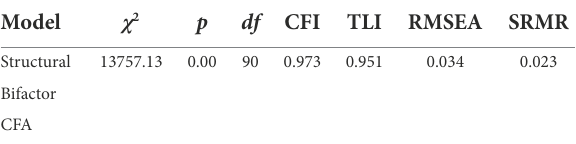
TABLE 5 Fit indices for the structural model based on bifactor CFA L2 grit predicting language achievement over time.